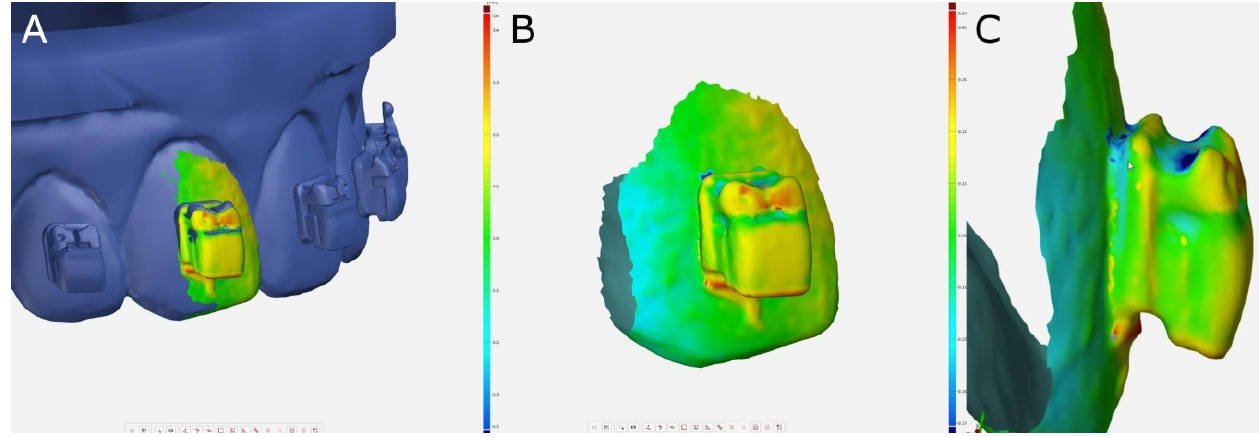
Figure 5. ( A ) Measurement procedure. ( B ) Frontal and ( C ) right lateral views of the segmented tooth 1.1. Warm colors represent a volume increase, cold colors represent a volume decrease, and green represents an accurate alignment.